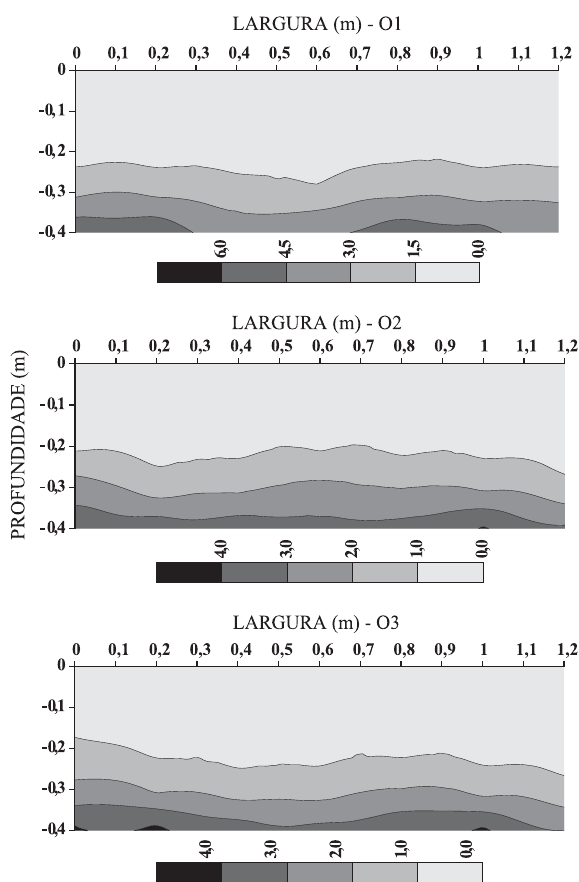
Figura 2. Mapa de isolinhas do atributo RP (MPa) no perfil do solo preparado com uma (O1), duas (O2) e três (O3) operações do